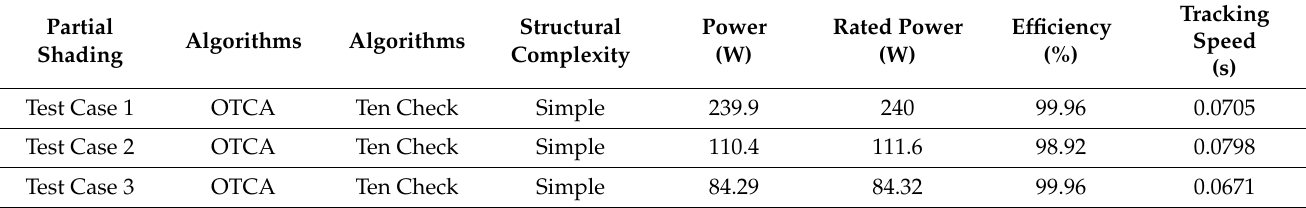
Table 7. Performance comparison of OTCA for 4S2P PV system for all test